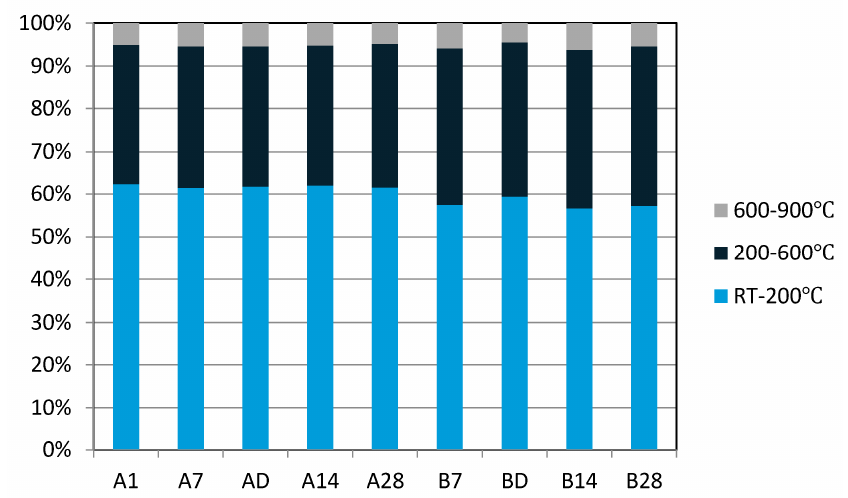
Figure 2. Percentage weight loss with temperatures ranging from room temperature to 900 °C.